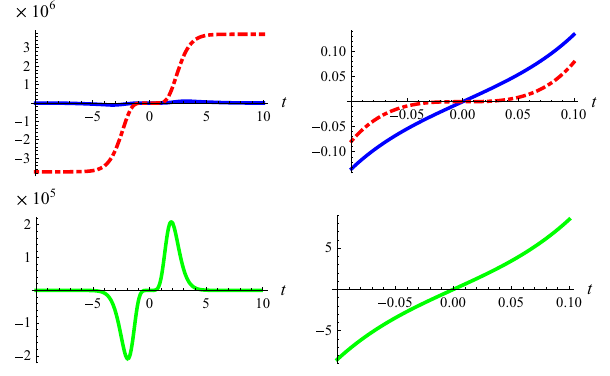
Fig. 3 Time evolutions of ϕ χ (blue, line), (cid:19) (red, dash dotted) and δ v (green, dotted). The upper panels show the behavior of ϕ χ and (cid:19) at a large scale (left) and in a region close to the bouncing (right). The lower panelsshow thebehaviorof δ v atalargescale(left)andinaregionclose to the bouncing (right). We choose c = 0 . 5, s = 1, t 0 = 0, n = 10, and K = 1. The initial conditions are set to ϕ χ ( 0 ) = 0 and ˙ ϕ χ ( 0 ) =